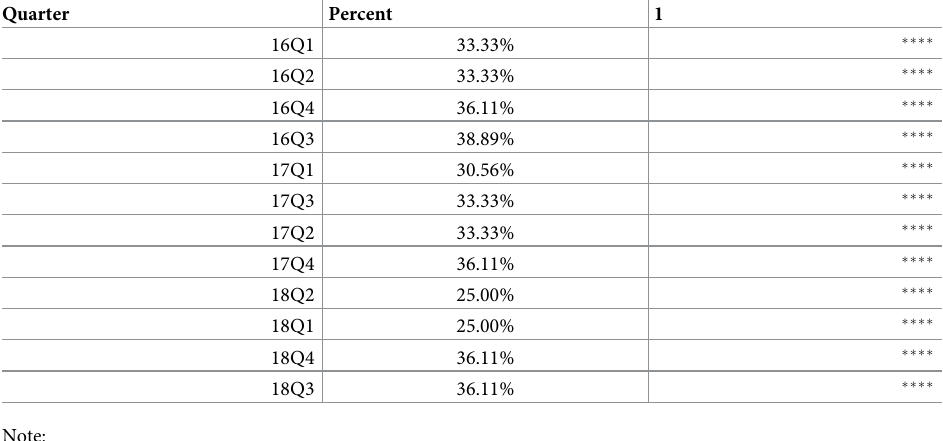
Table 5. Homogeneous groups for the occurrence of frequented item sets of web parts related to Pillar 3 for the year a) 2016, b) 2017 and c) 2018. Quarter